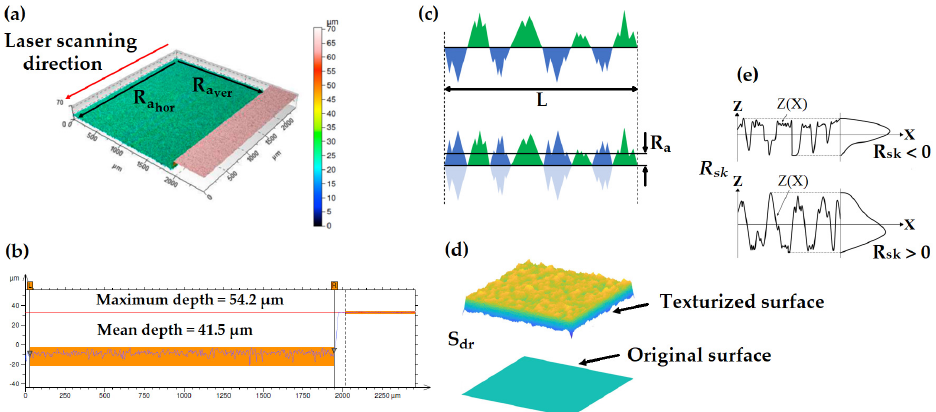
Figure 4. Example of measurement with profilometer applied to stainless steel in the case of increasing gradient: ( a ) reconstructed 3-D surface profile of the textured surface where the laser scanning direction is specified. The overall roughness is averaged between the horizontal roughness R a hor (parallel to the scanning direction) and the vertical roughness R a ver (perpendicular to the scanning direction) and over three measurement repetitions, ( b ) measurement of the depth after ablation, ( c ) schematic illustration of the definition of roughness R a , ( d ) developed interfacial area ratio S dr and ( e ) skewness of the roughness profile R sk . See text for